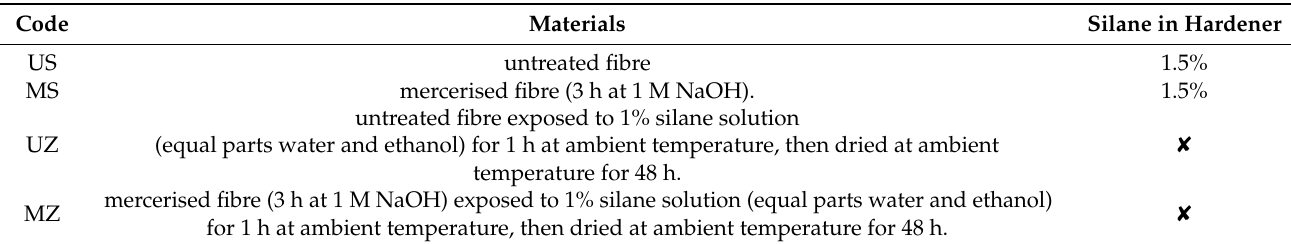
Table 3. Fibre treatment processes applied before composite manufacture. Code Materials Silane in Hardener US untreated fibre 1.5% MS mercerised fibre (3 h at 1 M NaOH). 1.5% untreated fibre exposed to 1% silane solution UZ (equal parts water and ethanol) for 1 h at ambient temperature, then dried at ambient temperature for 48 h. mercerised fibre (3 h at 1 M NaOH) exposed to 1% silane solution (equal parts water and ethanol) MZ for 1 h at ambient temperature, then dried at ambient temperature for 48